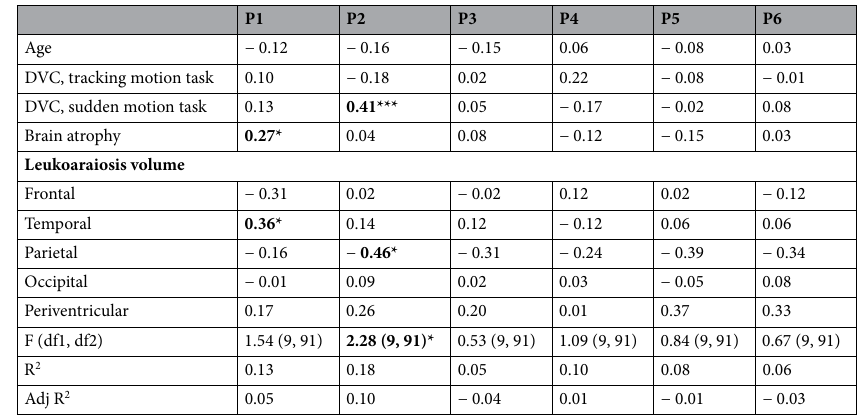
Table 4. Relationships of DSP scores with leukoaraiosis and brain atrophy. Significant values are in bold. DSP driving safety performance, DVC dynamic visual cognition, P1 changing lanes while driving straight, P2 turning right at an intersection, P3 straight course, P4 turning left at an intersection with a stop sign, P5 large curve with poor visibility, P6 turning left at an intersection; * p < 0.05, *** p < 0.001.